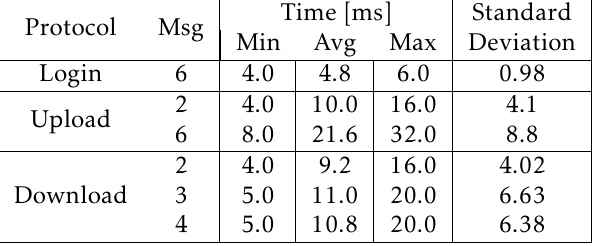
recorded during the experiment, along with the time consumption average and the standard